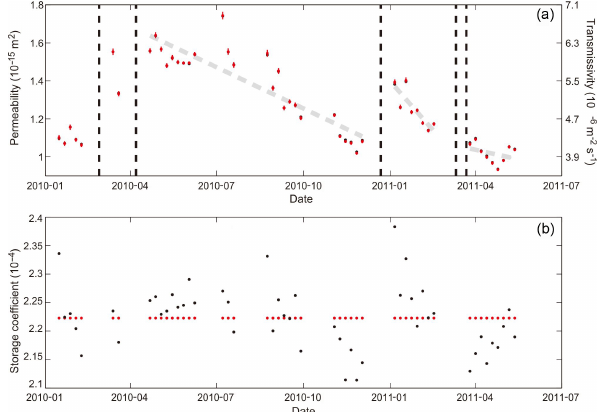
Figure 14. Hydrogeologic properties of the well–aquifer system over time for the WFSD-1 (Xue et al., 2013). (a) Permeability and transmissivity; (b) storage coefficient. Values were inverted from the phase and amplitude of each 29.6-day segment based on the an- alytical model. Segments that overlap the remote earthquakes (ver- tical dashed lines) were not inverted. The black dots denote an un- constrained inversion; the red dots are the results of inversion with the storage coefficient fixed to a single value. The best-fit linear trends between each set of permeability data are shown as light gray dashed